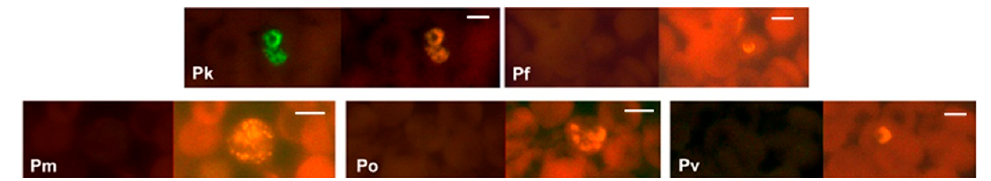
Figure 4. Specificity of the PK-FISH test for P. knowlesi. Photographs showing PK-FISH test results with the P. knowlesi -specific probe (green fluorescence) and the Plasmodium genus-specific probe (orange fluorescence) in blood smears containing P. knowlesi from monkey blood ( Pk ), and from human blood with confirmed infections of P. falciparum ( Pf ), P. malariae ( Pm ), P. ovale ( Po ) and P. vivax ( Pv ). Each set of paired photographs shows fluorescence in the same field when viewed in a LED fluorescence microscope with appropriate light filters (Figure S1). The scale bars represent